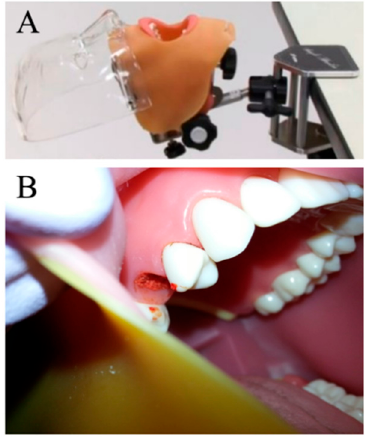
Figure 1. (A) phantom; (B) the extraction socket of the right maxillary second premolar Figure 1. ( A ) phantom; ( B ) the extraction socket of the right maxillary second